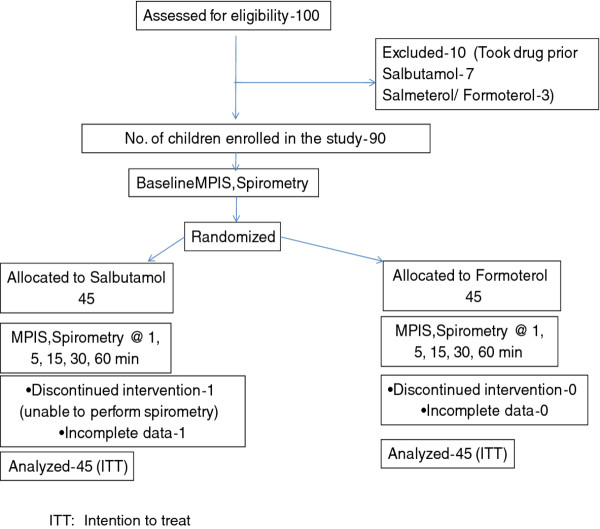
Trial profile. ITT: Intention to treat.